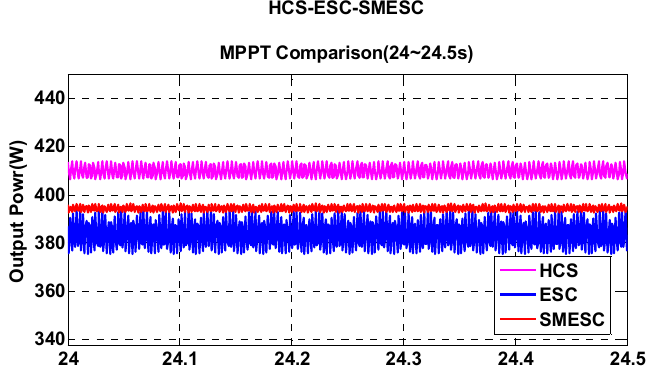
Figure 16. Output dynamic response of HCS, ESC and SMESC algorithms, respectively (constant wind speed) (24–24.5